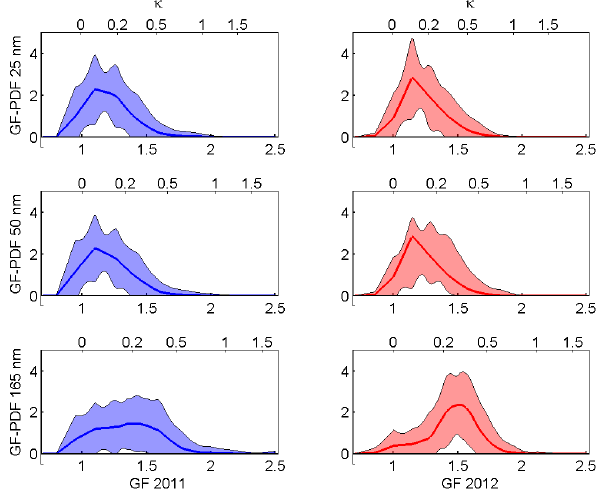
Figure 2a. Yearly average GF-PDFs and their standard deviations for particles in the nucleation mode (top panels), the Aitken mode (middle panels) and the accumulation mode (bottom panels), mea- sured at RH90. The bottom axis gives the growth factor GF and the top axis shows the corresponding kappa value κ .